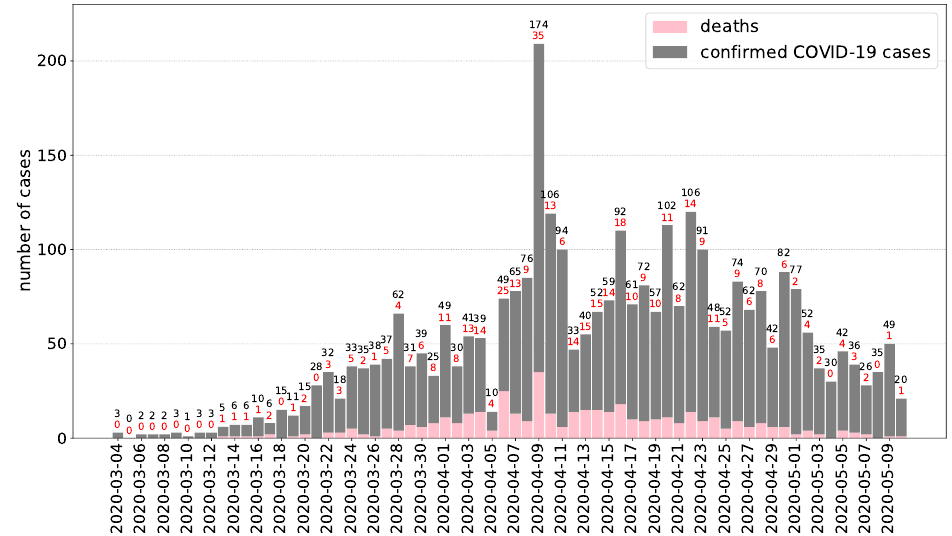
Figure 3. Epidemic curve of confirmed COVID-19 cases in Hungary by date of confirmation (reported until May 10, 2020. Data source: NPHC).